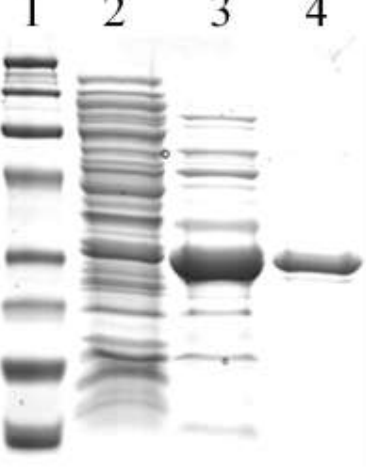
Figure 2. SDS-PAGE stained with Coomassie blue of ( 1 ) molecular weight markers (Bio-Rad; from top: 100, 75, 50, 37, 25, 20, 15 and 10 kDa); ( 2 ) the soluble protein fraction; ( 3 ) the TupA fraction after anionic exchange chromatography; and ( 4 ) the TupA fraction after molecular exclusion chromatography (approximately 15 µg of pure